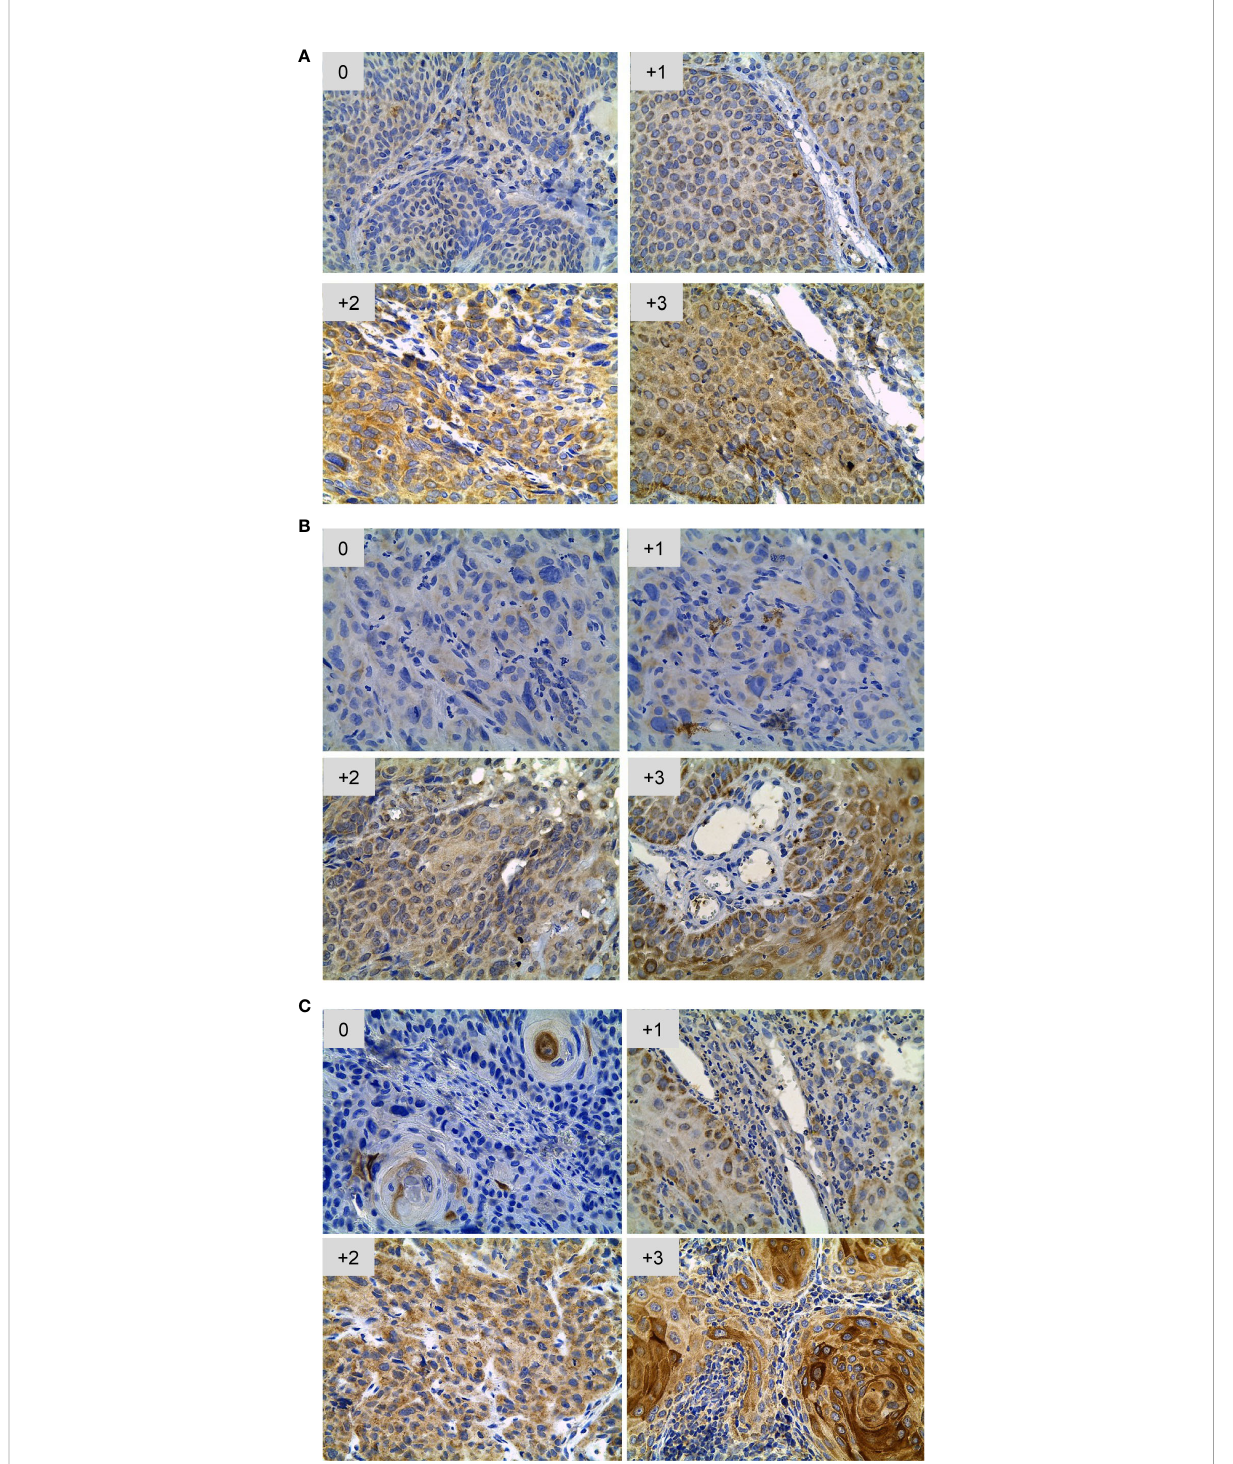
FIGURE 1 Scoring system for immunohistochemical staining of TLR2 (A) , TLR4 (B) and TLR9 (C) in OSCC. Each panel shows representative pictures of the increasing scores (from 0 to +3) according to the different expression levels of TLR expression. The intensity of the staining is designated as 0 when no tumor cells are stained; 1+ when 10- 20% of cells are stained (weak), 2+ when 20- 50% of cells are stained (moderate), and 3+ when >50% of cells are stained (strong). Micrographs were obtained at